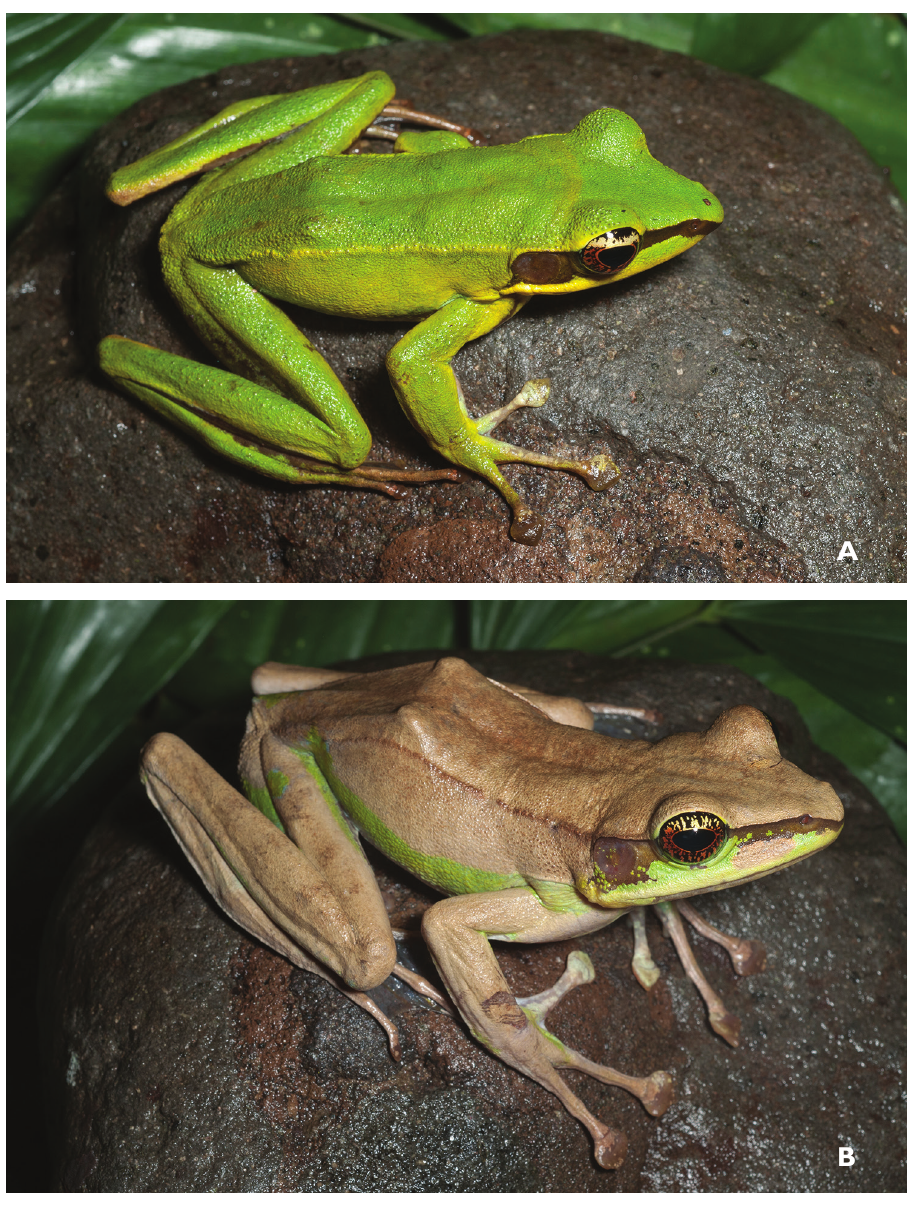
Figure 26. Sanguirana albotuberculata male ( A KU 333000) and female ( B KU 333001) from Mt. Hilong-hilong, Municipality of Remedios T. Romualdez, Agusan del Norte Province. Photos: RMB. ippines (Alcala and Brown 1998). Arifin et al. (2011) demonstrated the distinction between Palawan faunal region populations ( S. nubilis ) versus those of the Mindanao PAIC ( S. natator ); remaining taxonomic issues include the status of Basilan